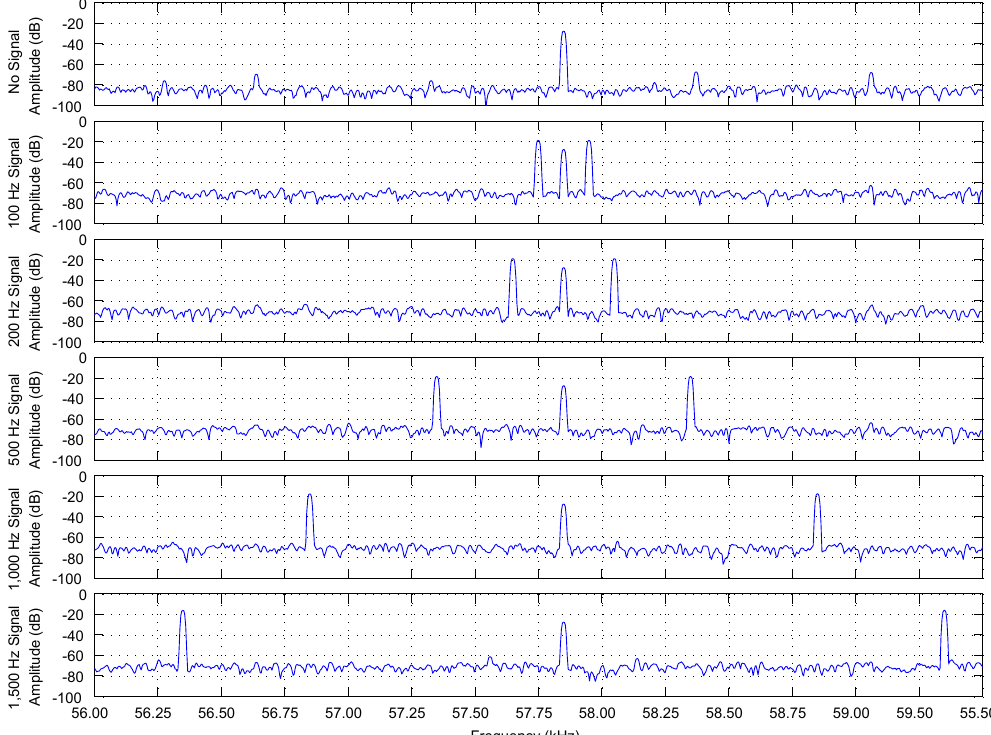
Fig. 8. Spectral analysis of the directly sampled error signal showing the modulation of the 2 f major carrier sidebands by applied sinusoidal magnetic signals up to 1500Hz.